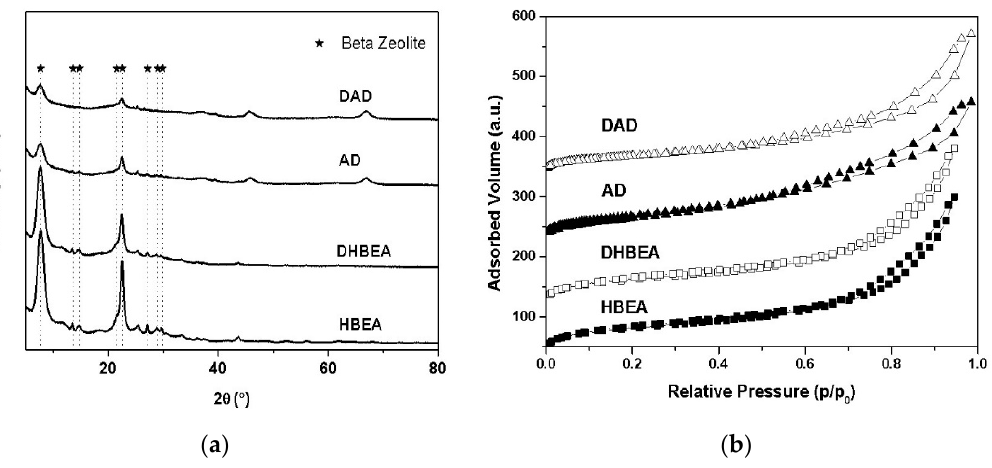
Figure 1. Characterization of beta zeolite and beta catalyst: ( a ) X-ray diffraction and ( b ) physisorption N 2 adsorption/desorption isotherm (various curves shifted upward for clarity). Legend: HBEA (Fresh beta zeolite); DHBEA (Hydrothermally treated beta zeolite); AD (Fresh beta catalyst) and DAD (Hydrothermally treated beta catalyst).